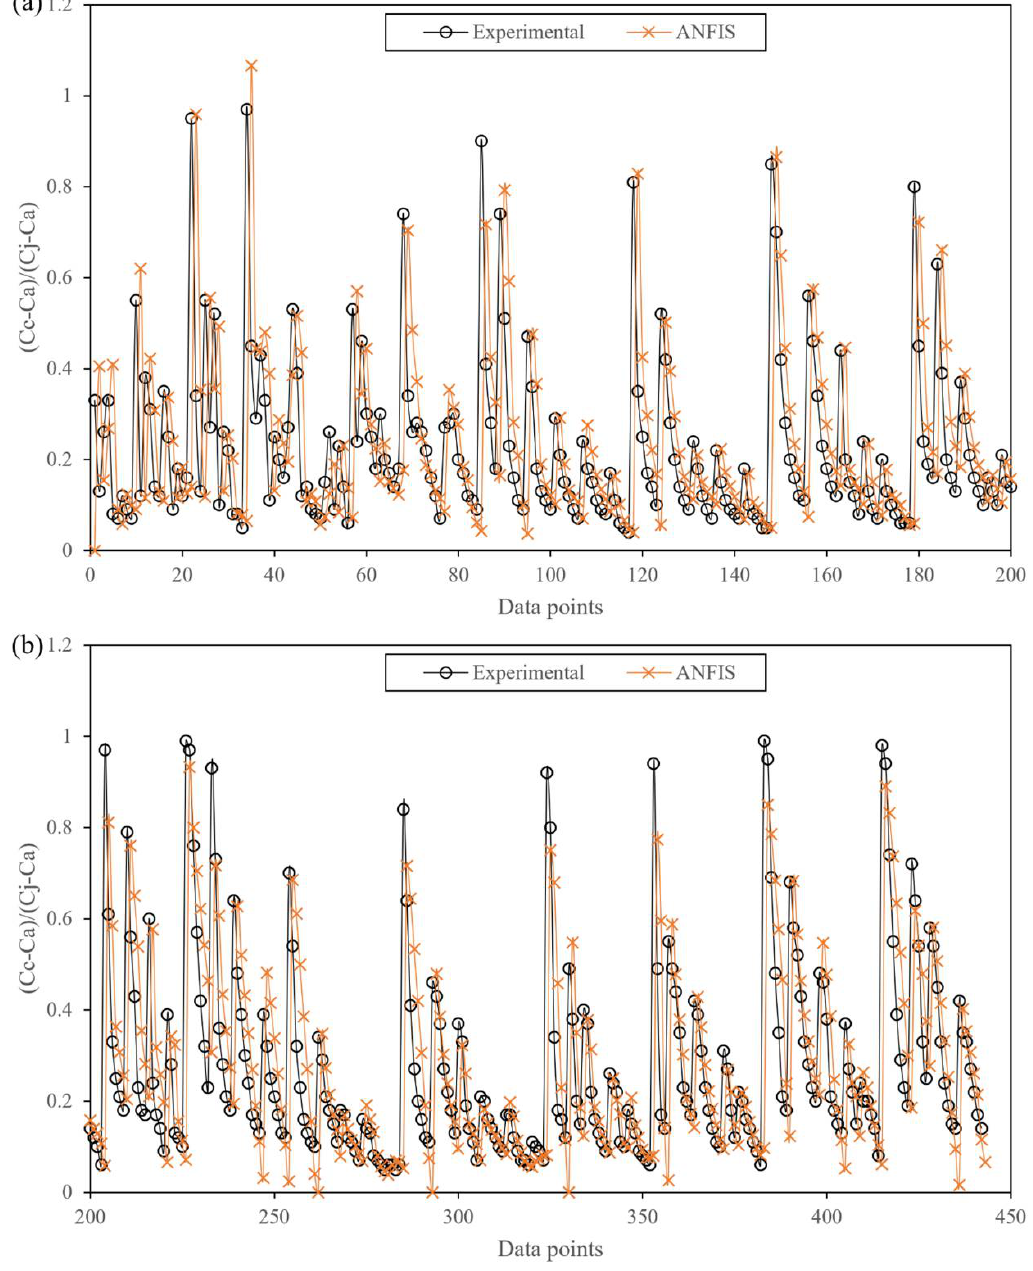
Figure 3. Comparison of the observed and predicted results for all of the data points: ( a ) data point number 0 ~ 200; and ( b ) data point number >200.